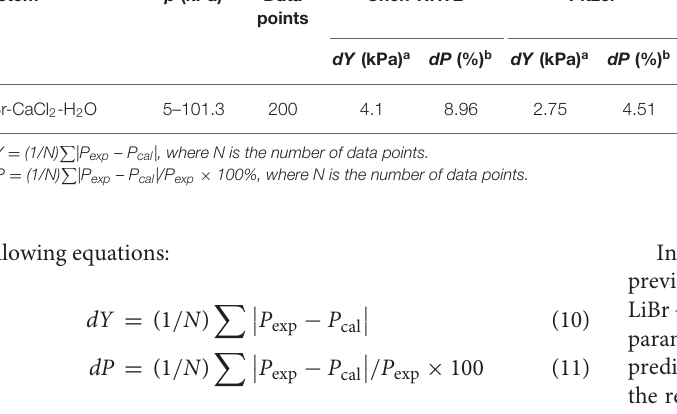
Chen-NRTL Pitzer This work (correlation points